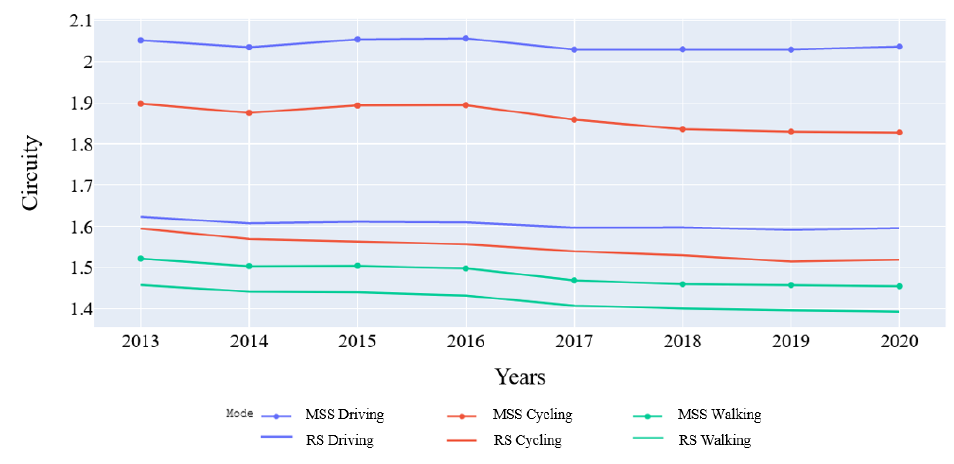
Figure 4. Average circuity for driving, cycling, and walking for 2013–2020 for the two sampling technique (MSS and RS).